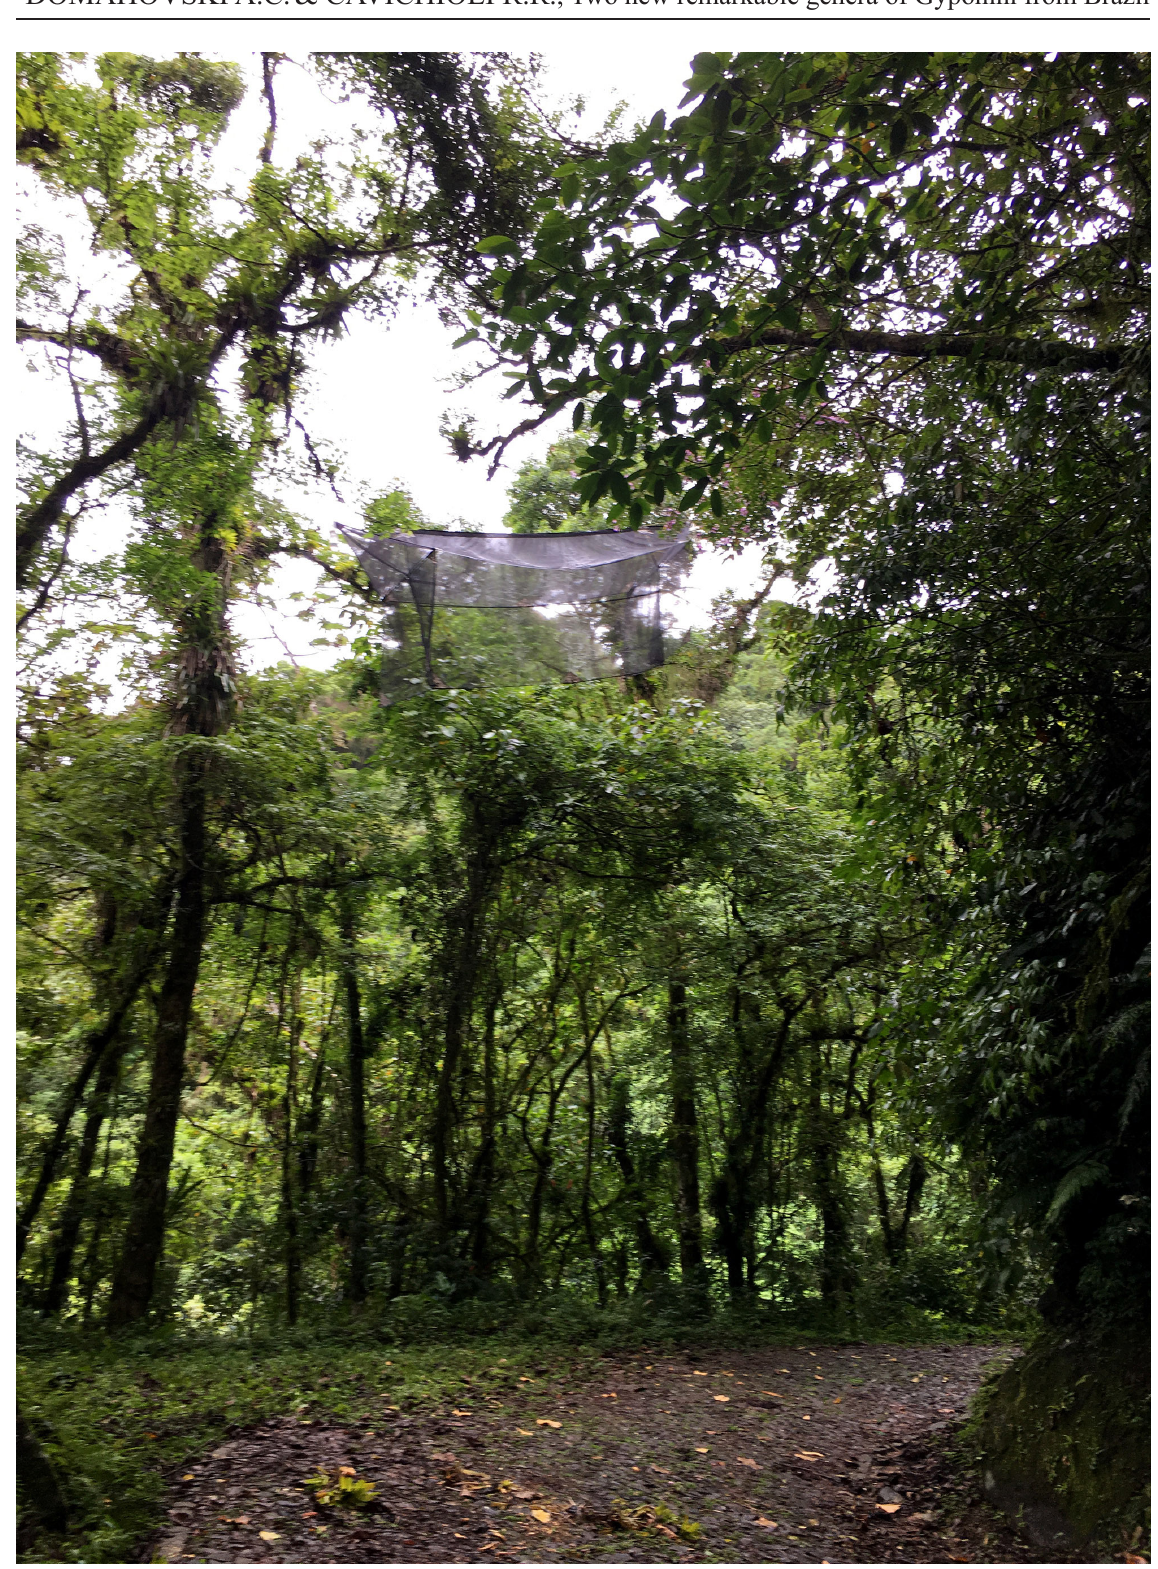
Fig. 1. Malaise trap suspended at approximately 15 m above the soil, placed near the Guaricana Hydroelectric Plant, Paraná,